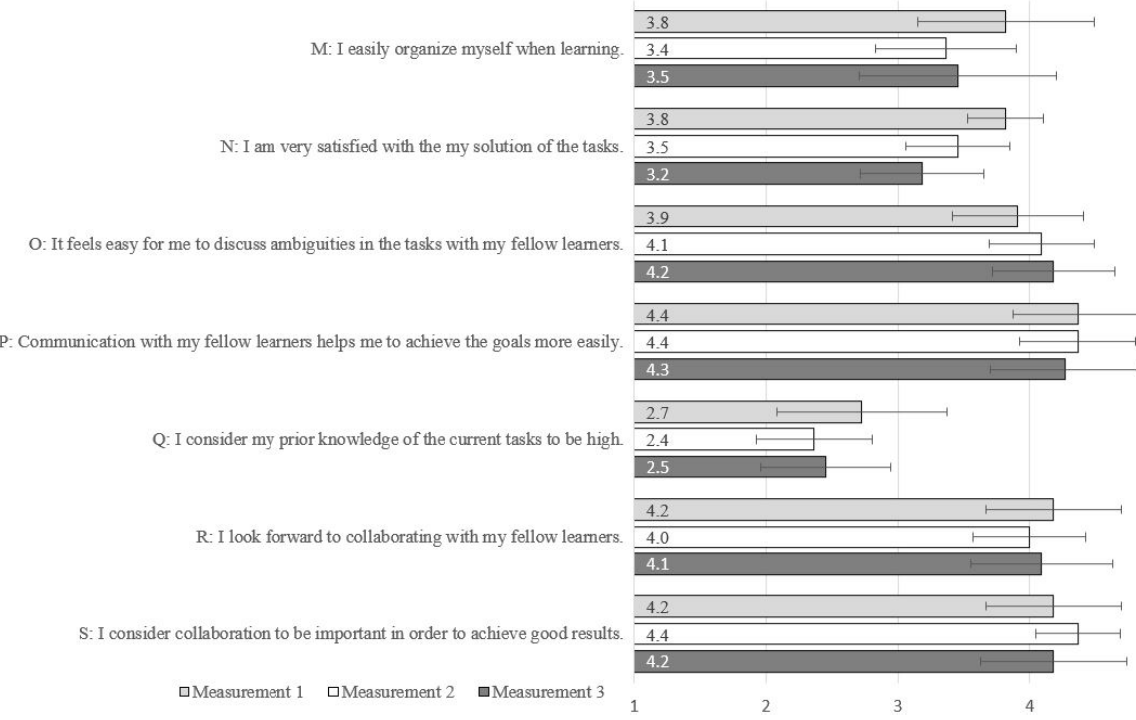
Figure 6. Items regarding self-organization and measurements ( n =